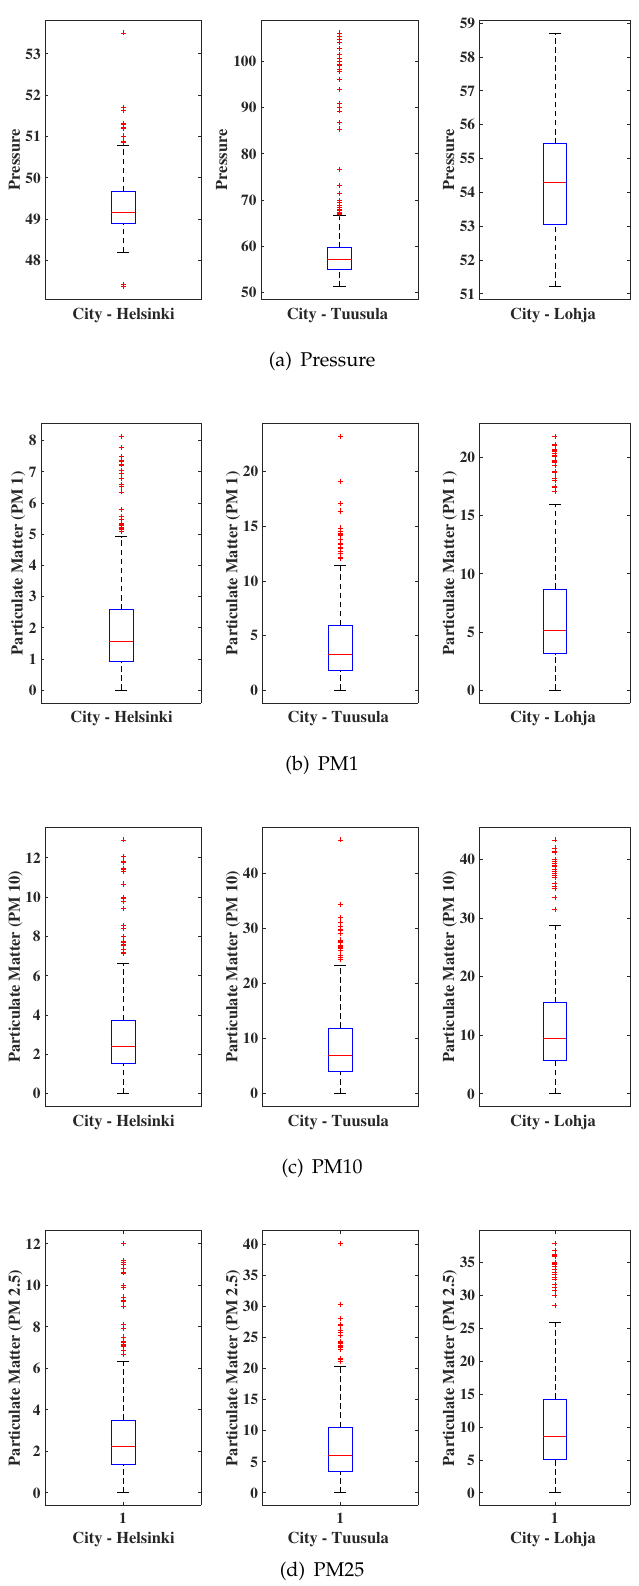
Figure 3. Time series of other data